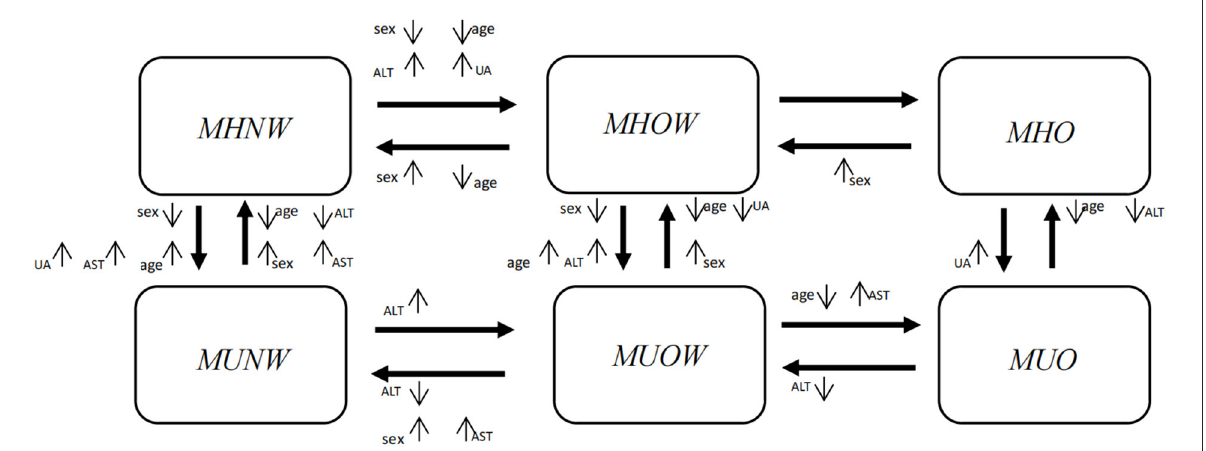
FIGURE4 Factors showing the significant effects on transitions from one phenotype to another in a multiple variable analysis. Significant factors included sex, age, ALT, AST and UA. Sex, females vs. males; Age, middle-aged group ( > 45 years old) vs. young group ( ≤ 45 years old); ALT, elevated vs. normal; AST, elevated vs. normal; UA, elevated vs. normal. The direction of the arrow beside a factor denotes the significant impact of this factor on a certain transition. ↑ means the factor increases the probability of the transition compared with the reference level; ↓ means the factor decreases the probability of the transition compared with the reference level. ALT, alanine aminotransferase; AST, aspartate aminotransferase; UA, uric